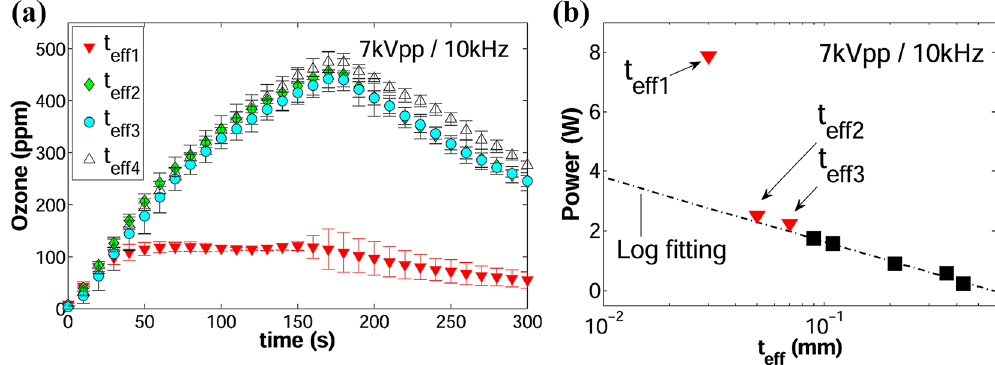
Figure 8. Experimental results corresponding to t eff 1 , t eff 2 and t eff 3 at 7 kVpp/10 kHz; t eff 4 is only added for reference. ( a ) Ozone levels vs. time. ( b ) Average power vs. t eff ; black square markers represent the range t eff 4 (left) to t eff 8